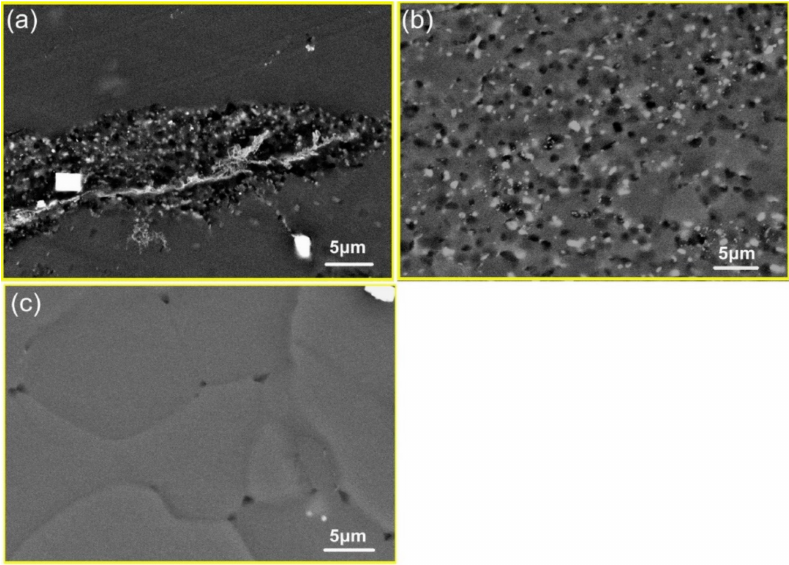
. ε = 0.002 s − 1 and T = 350 ◦ C, ( b )